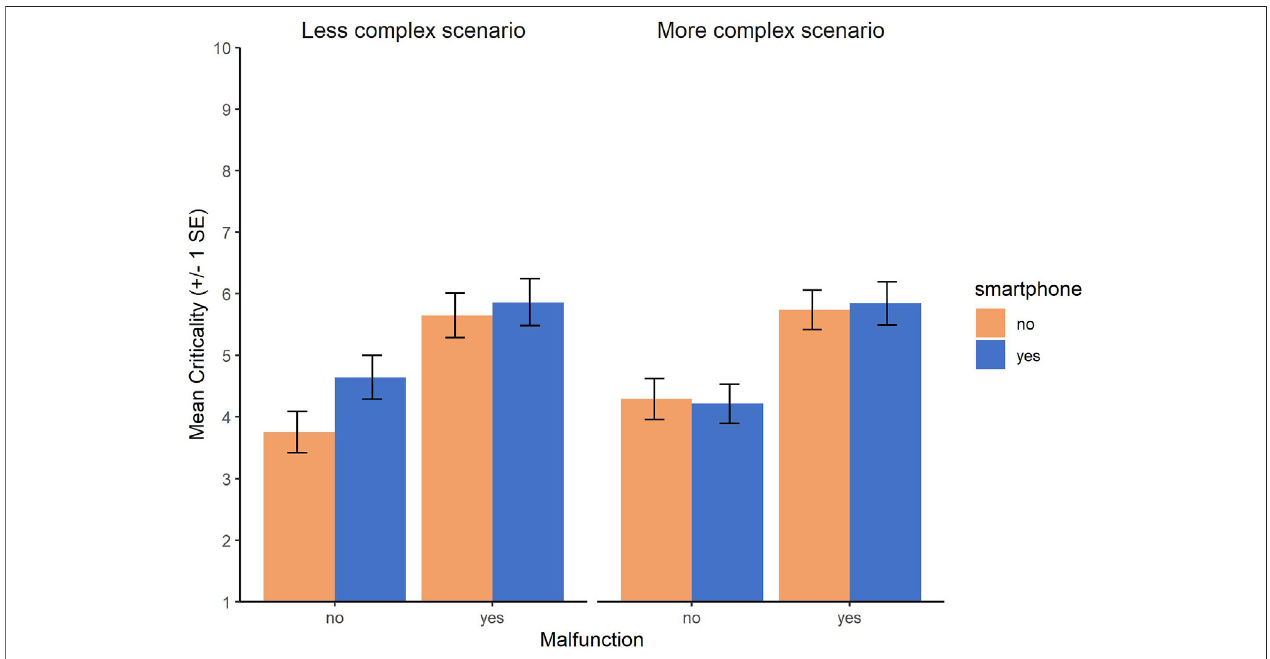
FIGURE 6 | Perceived criticality by system malfunction , crossing pedestrian ’ s smartphone use , and scenario complexity . Error bars represent standard errors. Higher ratings represent a higher perceived criticality. For results of signi fi cance tests, see text.